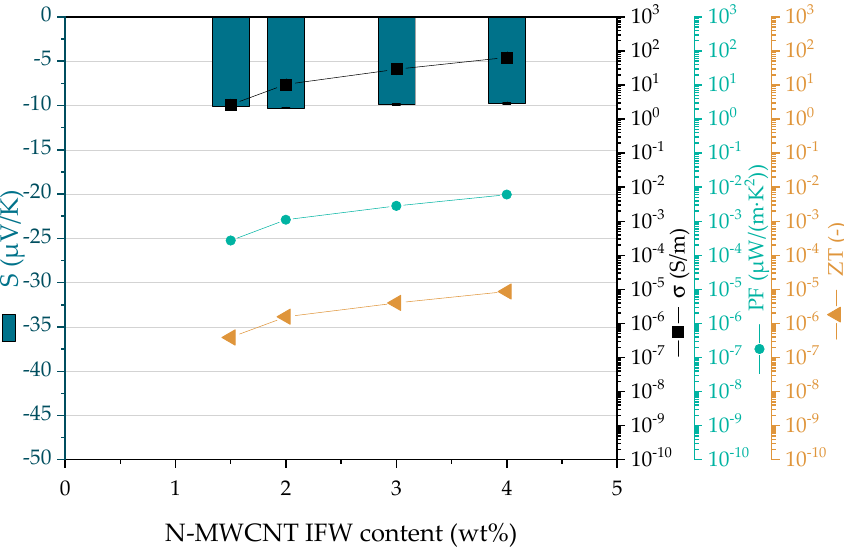
Figure 3. Thermoelectric properties of PP/N-MWCNT IFW composites at different nanotube contents. A comparison of the two N-MWCNT types was performed by comparing the values of PP composites filled with N-MWCNT A1 or N-MWCNT IFW. Despite the lower (negative) value of the sample with PP / N-MWCNT IFW, due to its higher electrical conductivity, this material showed